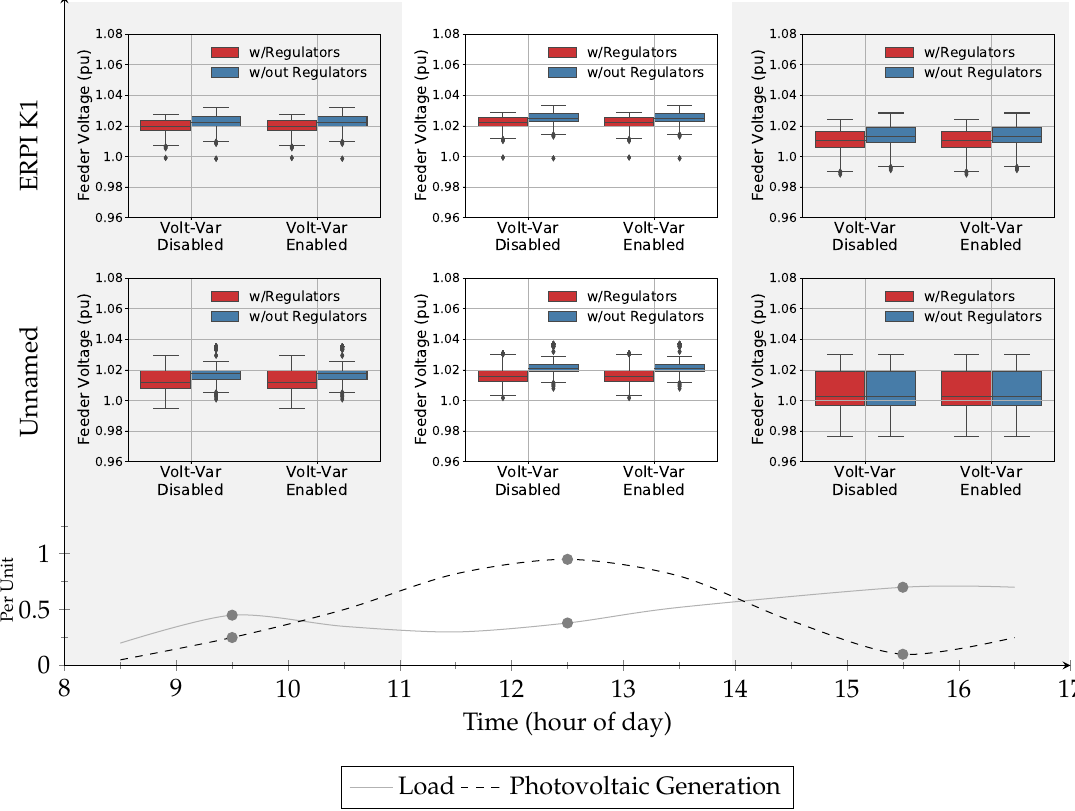
Figure 8. Box plots show each feeders’ overall voltage response to the corresponding load and distributed photovoltaic (PV) generation given in a per unit (pu) value. The EPRI K1 and Unnamed feeders’ voltage remained relatively constant throughout the day and resided closer to nominal with the help of conventional